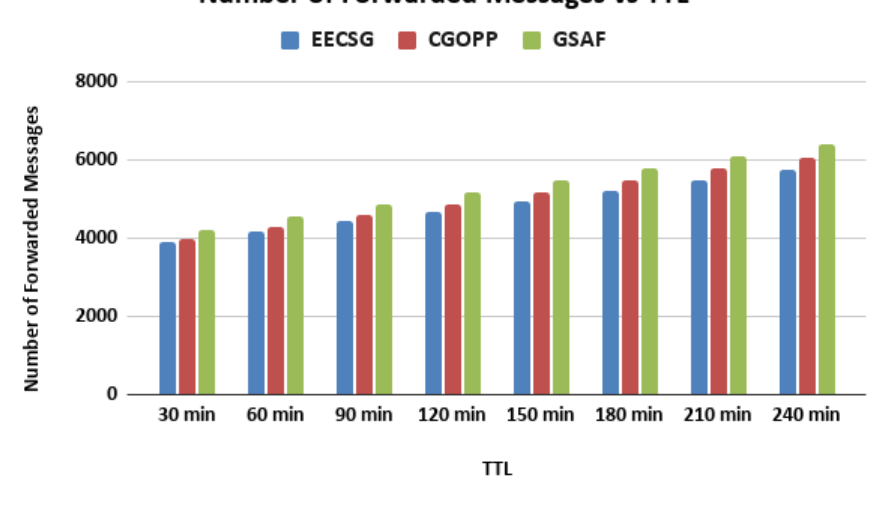
Figure 10. Number of forwarded messages vs. TTL.